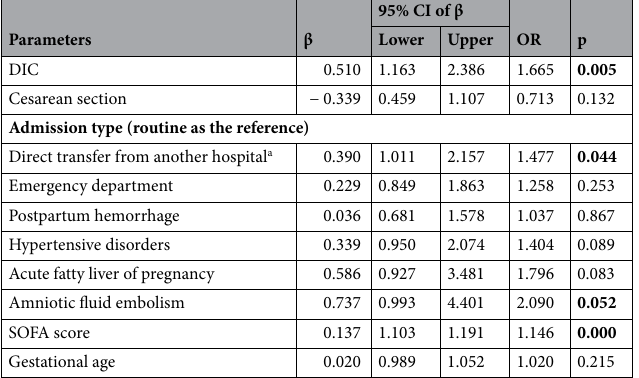
Table 3. Variables that were independently associated with changes in organ function in 297 obstetric ICU cases based on the ordinal regression model. Significant values are in bold. SOFA, Sequential Organ Failure Assessment. a Indicates that patients who were transferred directly to ICU wards from another